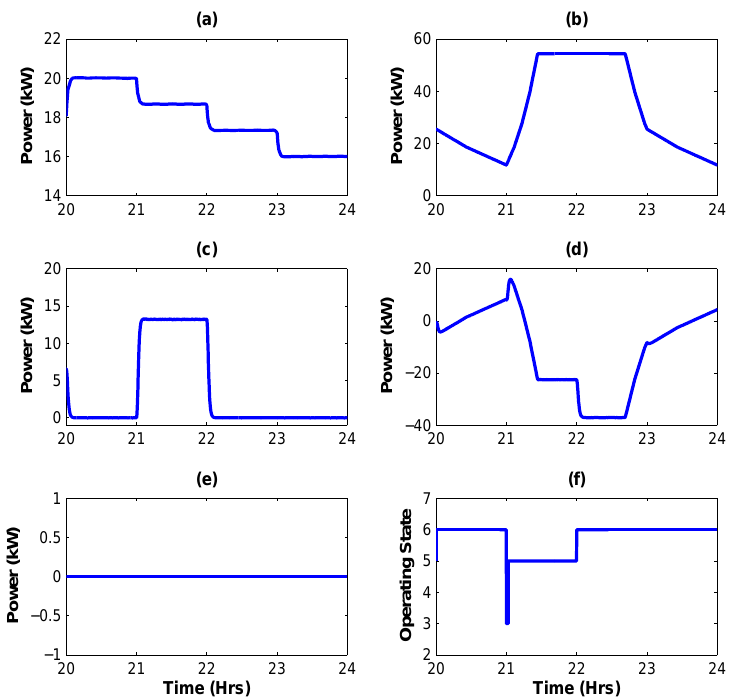
Figure 21. Simulation results for t = 20–24 h; ( a ) P DL , ( b ) P WT , ( c ) P CDi , ( d ) P NG , ( e ) P ES , ( f ) operating state.